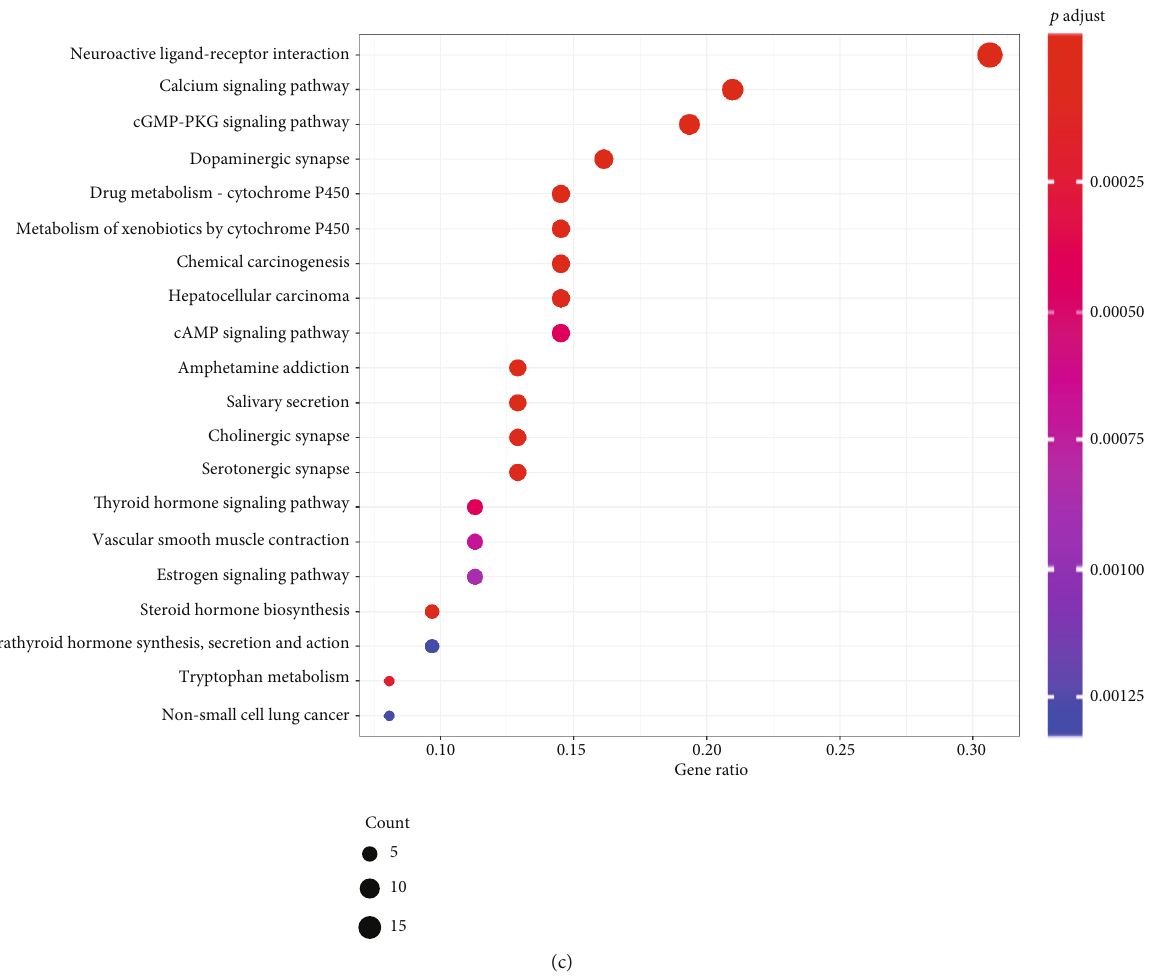
Figure 8: (a) KEGG pathway analysis of cluster 1. (b) KEGG pathway analysis of cluster 2. (c) KEGG pathway analysis of cluster